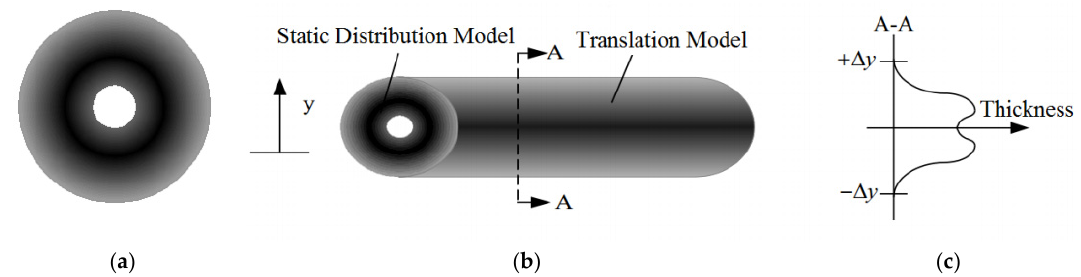
Figure 1. ( a ) Coating distribution of electrostatic rotating bell (ESRB); ( b ) Translation of the static distribution model; ( c ) the section thickness of the translation model.